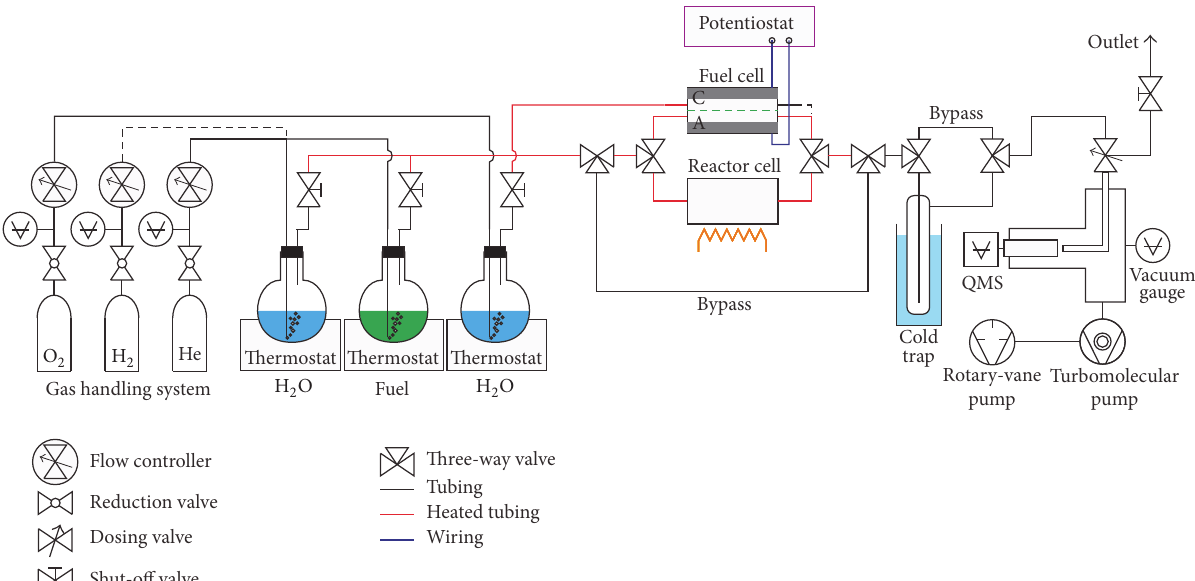
Figure 1: Schematic depiction of the experimental setup used for mass spectrometry of fuel